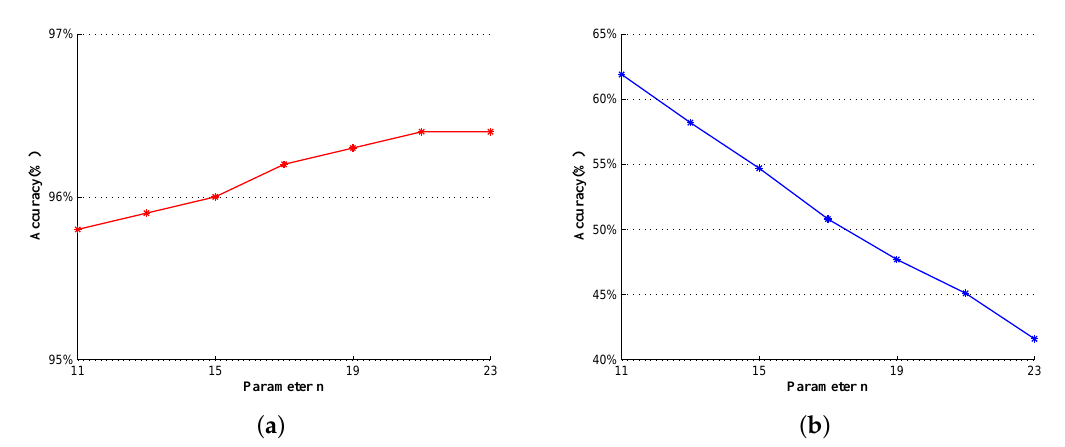
Figure 5. Mean precision and recall values of feature refinement with different n s (the number of candidate matched pairs nearest the seed matched pair). ( a ) mean precision; and ( b ) mean recall.